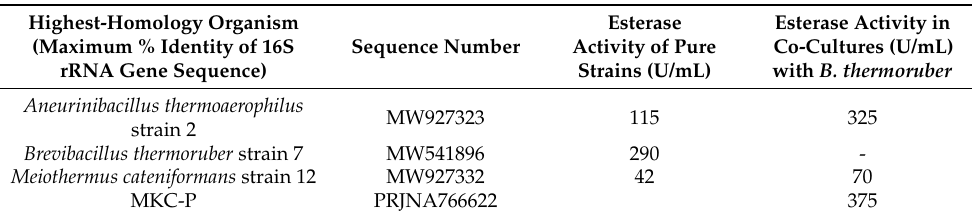
Table 3. Phylogenetic affiliation of the selected strains and esterase activity on 48 h of cultivation of the MKC-P and isolated strains alone and in a combination with B. thermoruber strain 7. Highest-Homology Organism (Maximum % Identity of